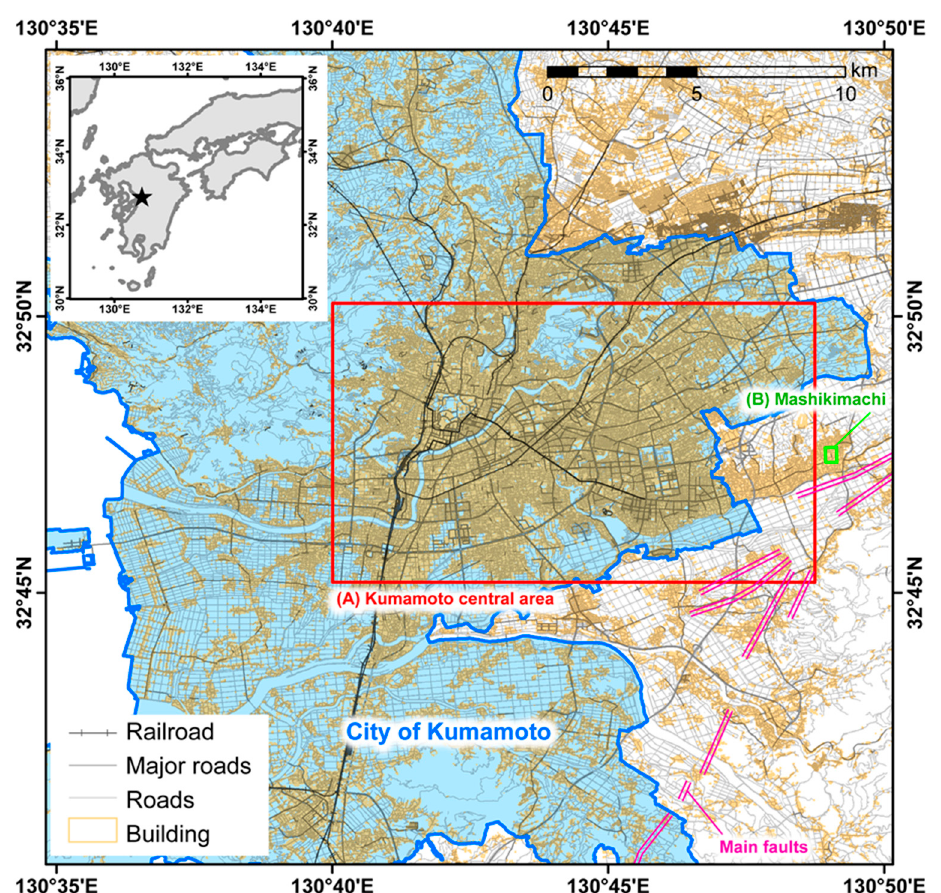
Figure 1. Study areas in the central Kumamoto, Japan city. An aerial photography survey is carried out in ( A ) a Kumamoto central area and an inventory survey is carried out in ( B ) Mashikimachi near the main faults for this earthquake.